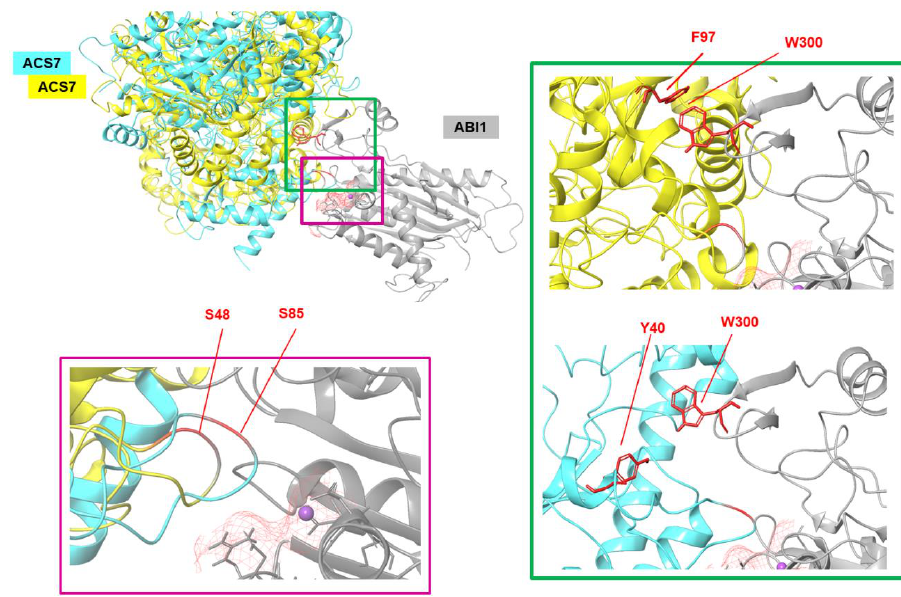
Figure 4. Summary model of the interactions between ACS7 and ABI1 PP2C. Zoomed-in view of the ACS7–ABI1 PP2C complex structure presented in ribbon style. Three-dimensional structures of proteins showing the binding sites and main residues involved in interactions. ABI1 PP2C with bound Mg 2 + metal ion is shown in gray. ACS7 (yellow, cyan) is presented in di ff erent orientation-based structures exposing the key S48 and S85 residues of ACS7 in the ABI1 PP2C binding pocket (left). W300 of ABI1 PP2C and F97 and Y40 of ACS7 are shown as red sticks